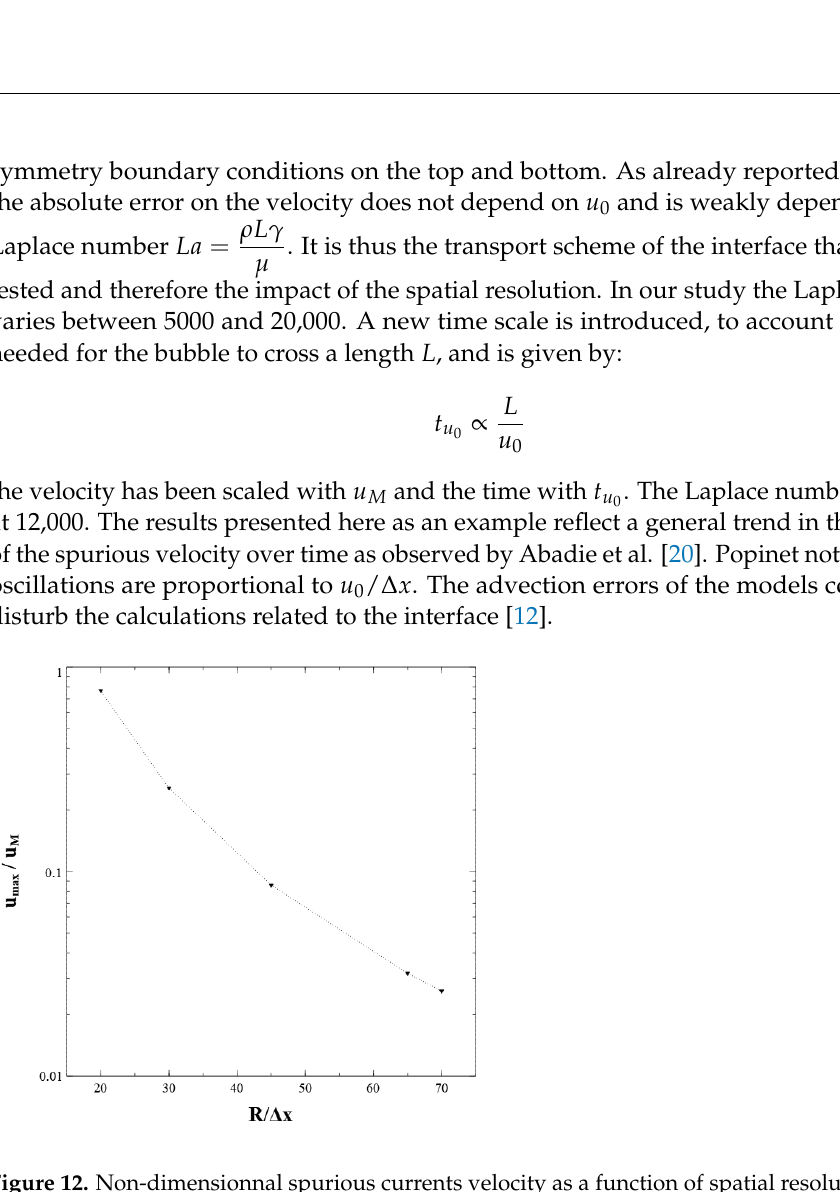
Figure 12. Non-dimensionnal spurious currents velocity as a function of spatial